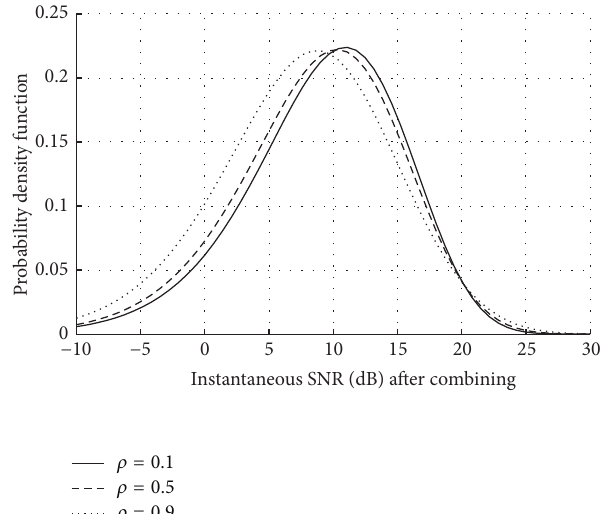
Figure 7: Probability density function of output SNR for a given transmit antenna ( 𝑇 = 1 ) and 𝑅 = 4 .